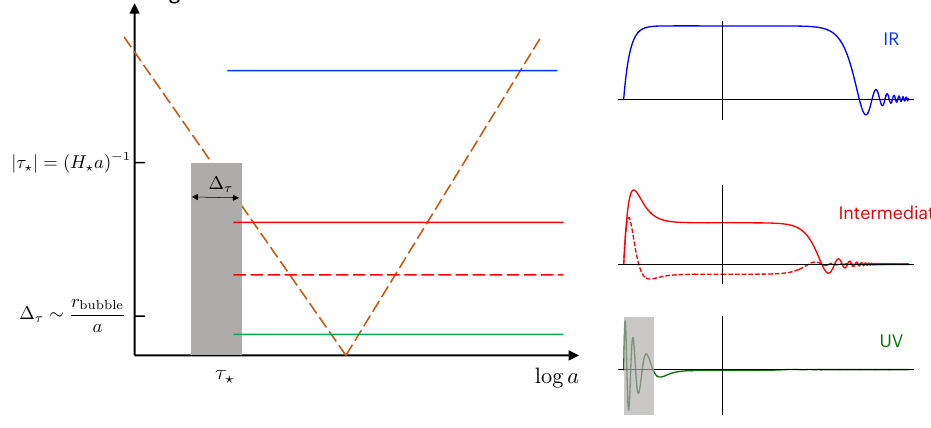
Figure 2 . Illustration of various relevant scales and corresponding GW signal. The bubbles nucleated during a phase transition collide, which give rises to a GW source around τ ? lasting for a short duration of ∆ τ (cid:28) ( H ? a ? ) − 1 , where H ? and a ? are the Hubble and the scale factor at the phase transition,